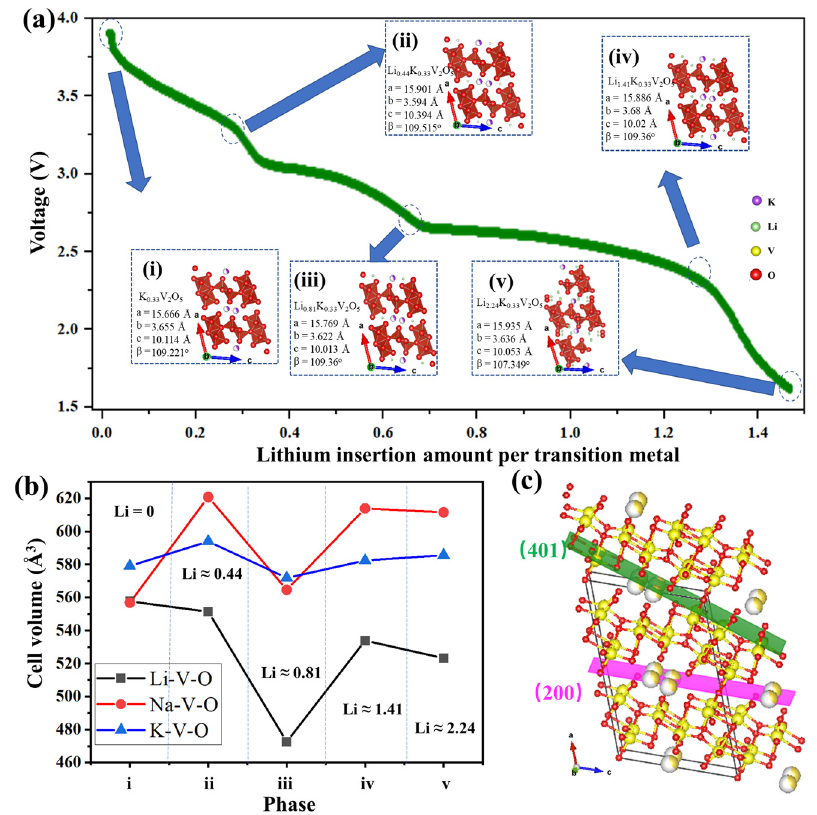
221 Figure 3. ( a ) Phase evolutions of K-V-O at different lithium insertion amounts within the voltage